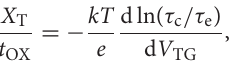
FIGURE 5 | Coulomb blockade observed in our device at 4.2 K. V FG1 = 0.5 V and V FG1 = 0 V. Conductance peaks are observed outside of the blockade